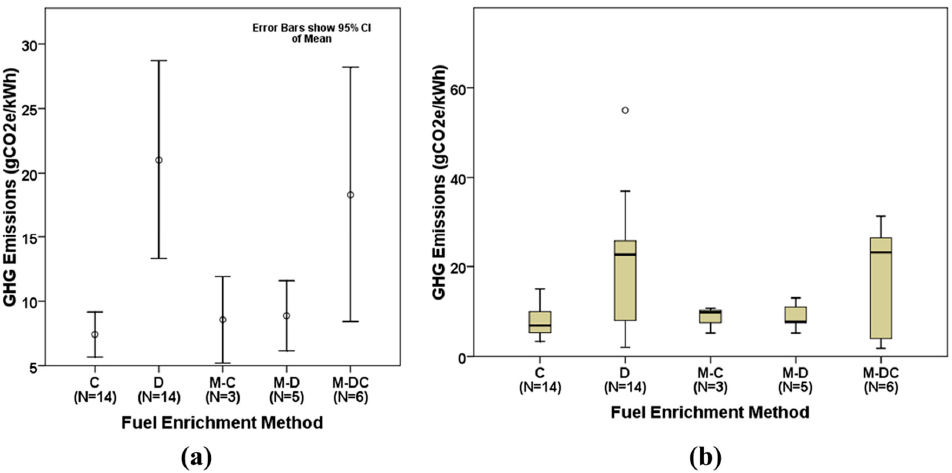
Figure 2. GHG emissions from different fuel enrichment methods: ( a ) mean ± 95% CI error bars; and ( b ) quartile box plots. Table 3. GHG emission (gCO 2 e/kWh) statistics from different fuel enrichment methods.